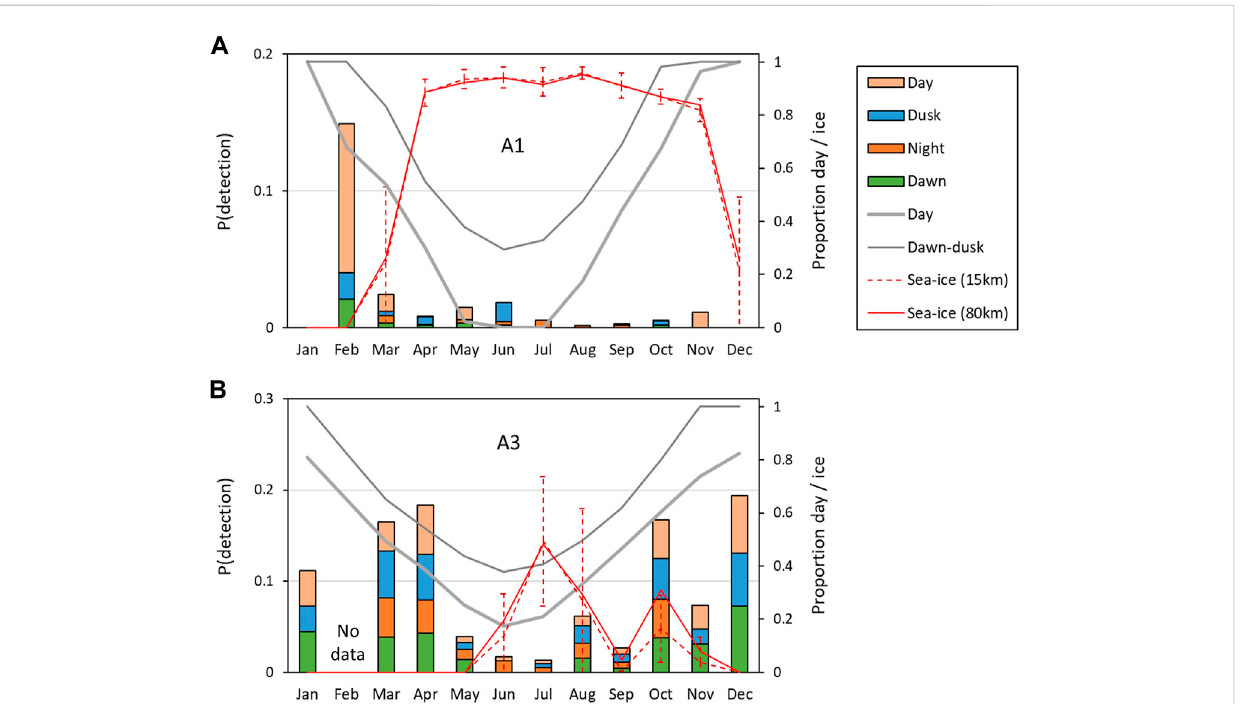
FIGURE 7 Average probability of detecting at least one sperm whale vocalization in an hour in a given month “ P (detection) ” . (A) Southern site A1; (B) northern site, A3. Overall probabilities of detection are shown on the left axis, and stacked-bar colours show the relative probabilities of detection during the day (sunabovethehorizon),nauticaltwilight(dawnanddusk)andatnight(sunelevation < 12 ° ).Theaverageproportionofdaylightandtwilightinthemonthis shown by the solid grey lines (right axis). The average monthly ice concentration (red lines) and standard-deviations within the month (red dashed vertical bars) are also shown on the right axis for two ranges (15 and 80 km).